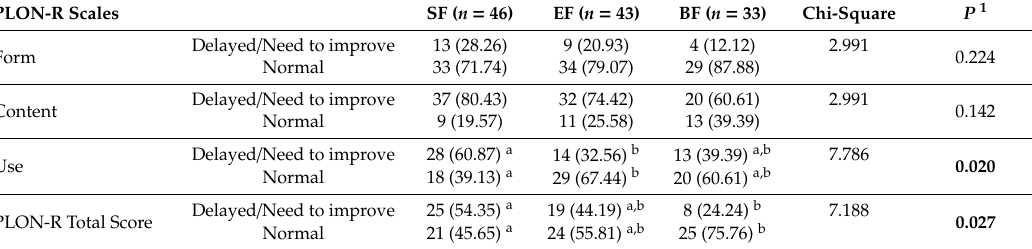
Table 3. Association between infant formulas and PLON-R clinical clusters in children at four years old. PLON-R Scales